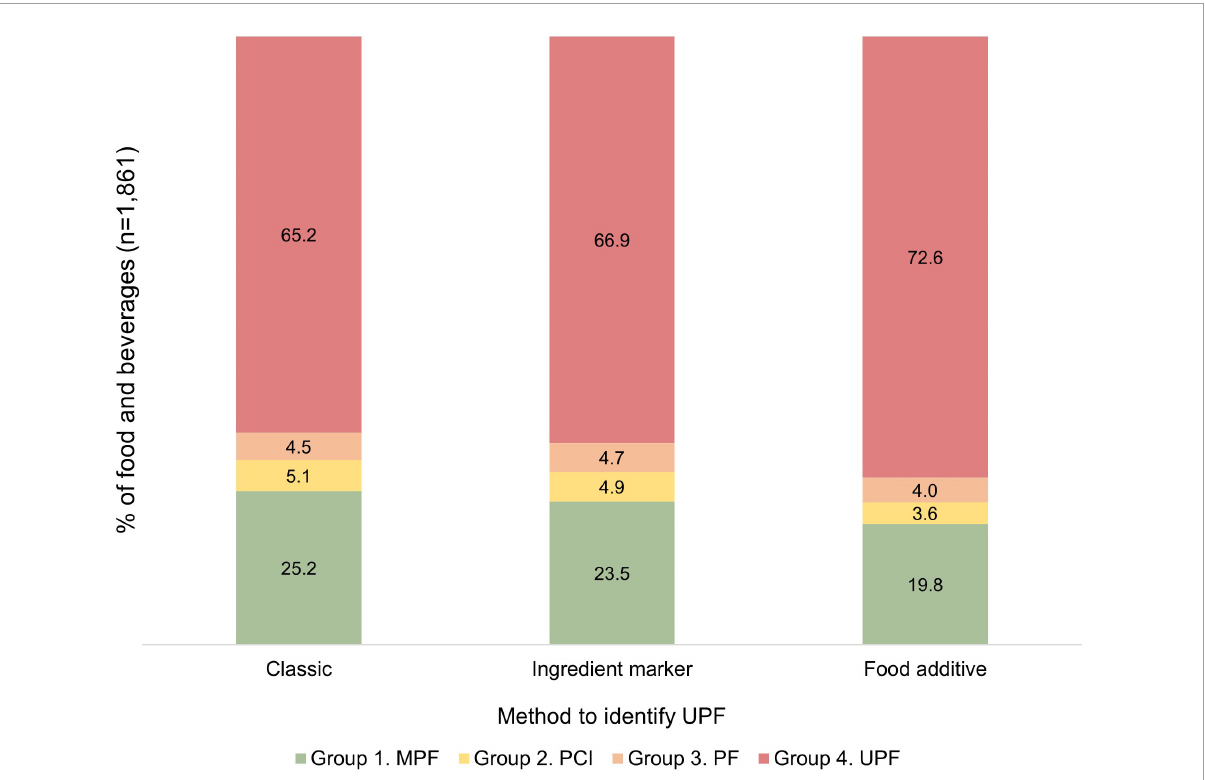
FIGURE1 Proportion (%) of NOVA food groups using three methods to identify UPF in foods and beverages ( n = 1,861). MPF, minimally processed foods; PCI, processed culinary ingredients; PF, processed foods; UPF, ultra-processed foods. In “classic method,” UPF was identified by using food description; in “ingredient marker method,” by searching for substances not commonly used in traditional recipes and names of functional classes of cosmetic additives in the lists of ingredients; and in “food additive method” by searching for UPF ingredient markers, names of functional classes and all individual names of cosmetic